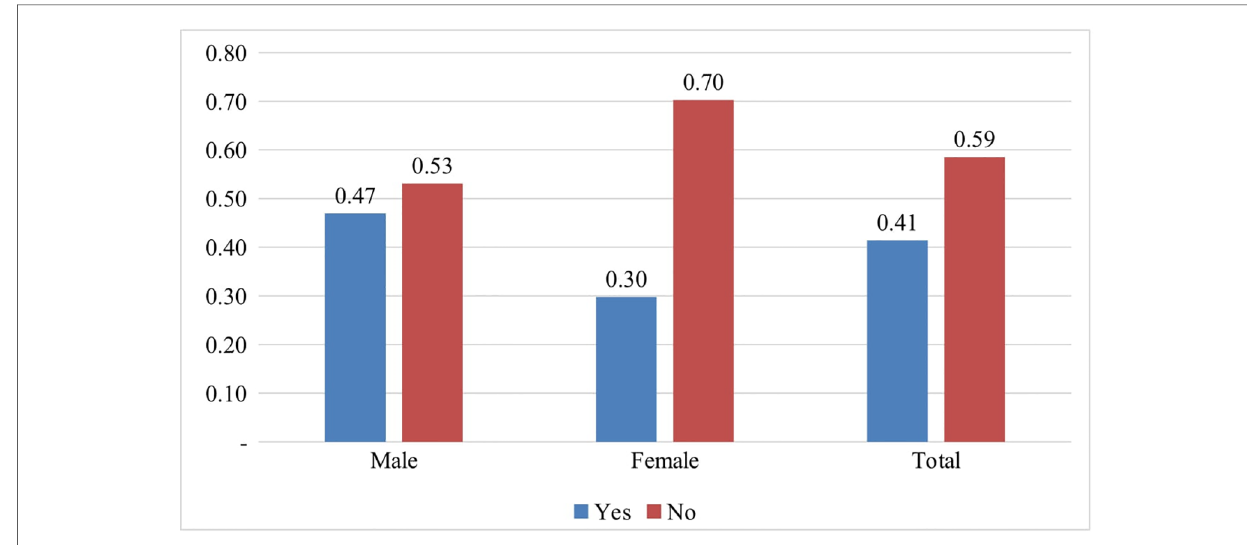
FIGURE 2 Prevalence in engagement in risky sexual behaviors among the